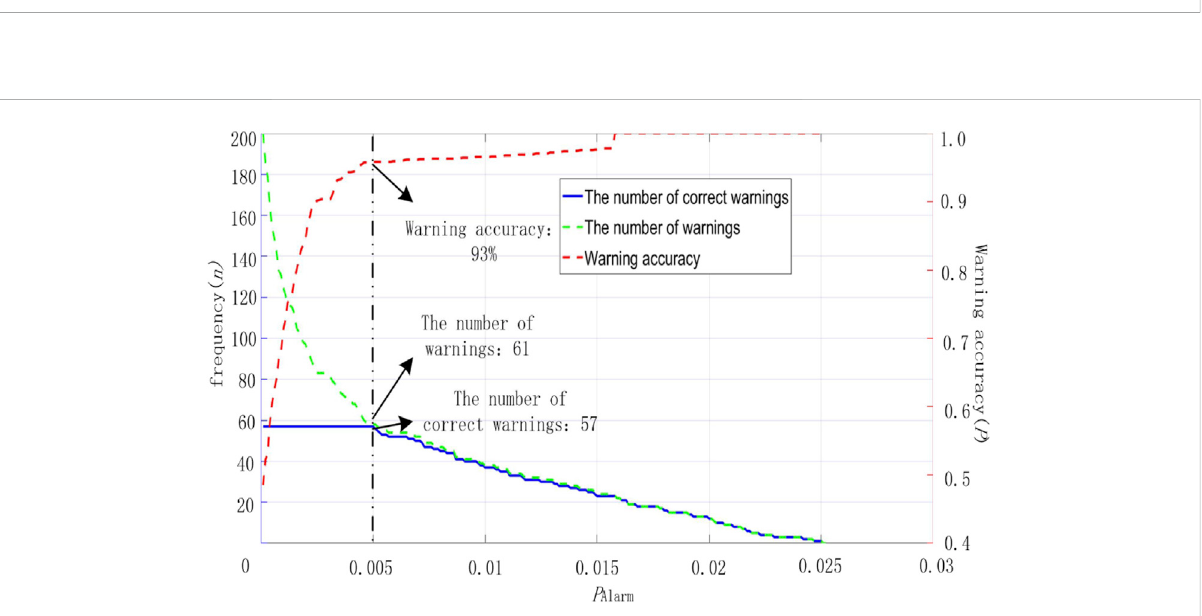
FIGURE 10 Optimization results of probability warning